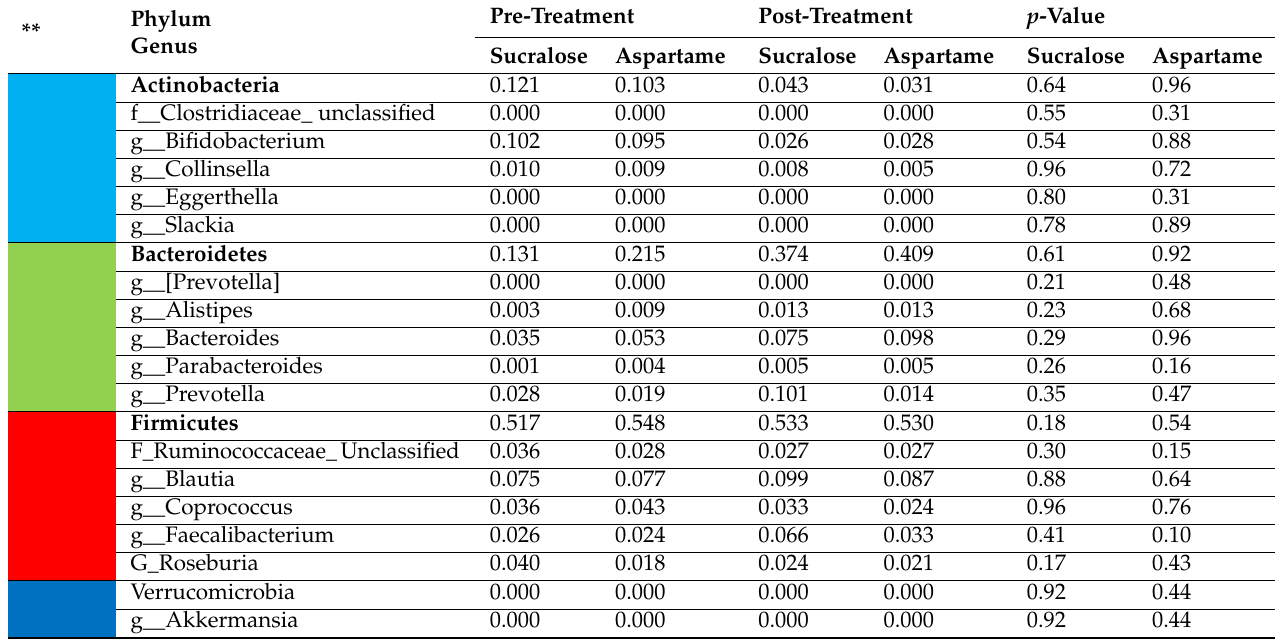
Table 4. Median relative abundance of the 5 most abundant genus-level taxa within the 4 most dominant * phyla before and after treatment with sucralose or aspartame drinks for 14 days in healthy adults ( n =